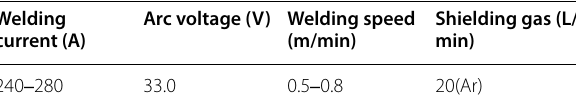
Table 2 Welding parameters Welding current (A)